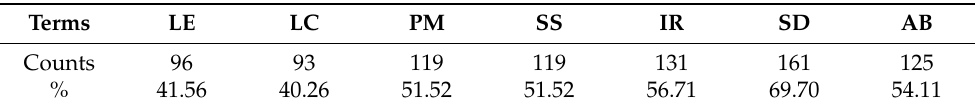
Table 4. The counts in the evaluation indicator, based on the post-value more than the pre-value, and its proportion to the sample (N =